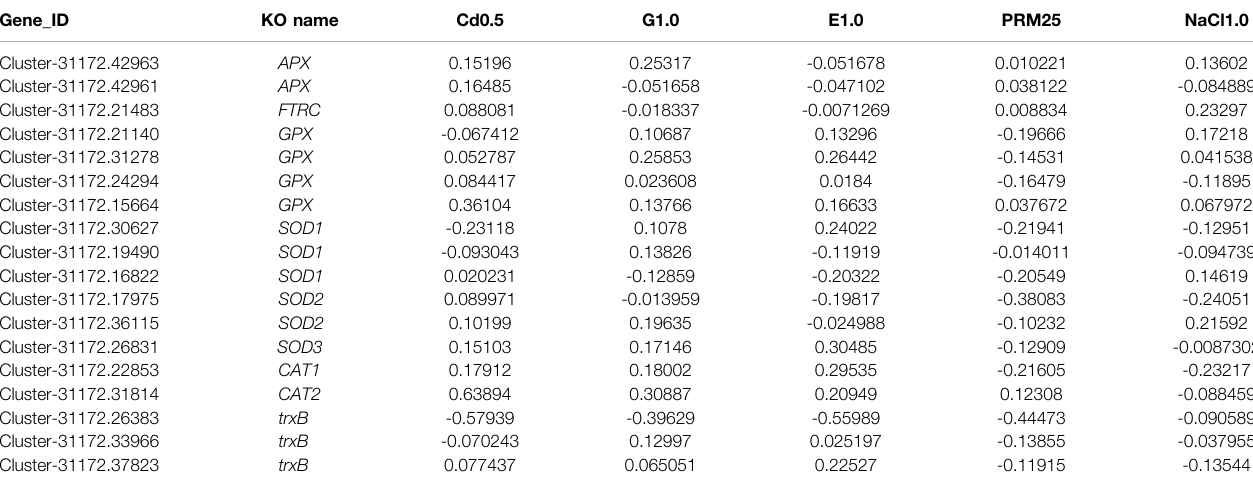
TABLE 2 | The Log2FC (fold change) of selected Reactive Oxygen Species (ROS) scavenging genes under different treatments, treatment vs. control.